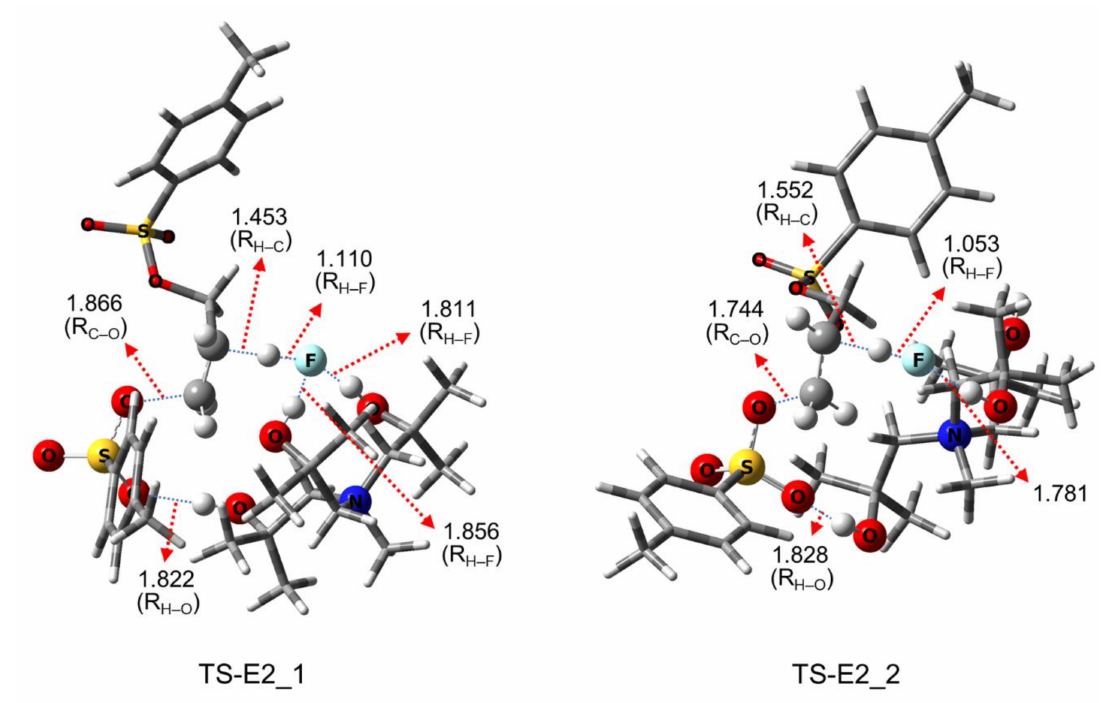
Figure 3. Calculated transition states of the E2 elimination of 1 in CH 3 CN.